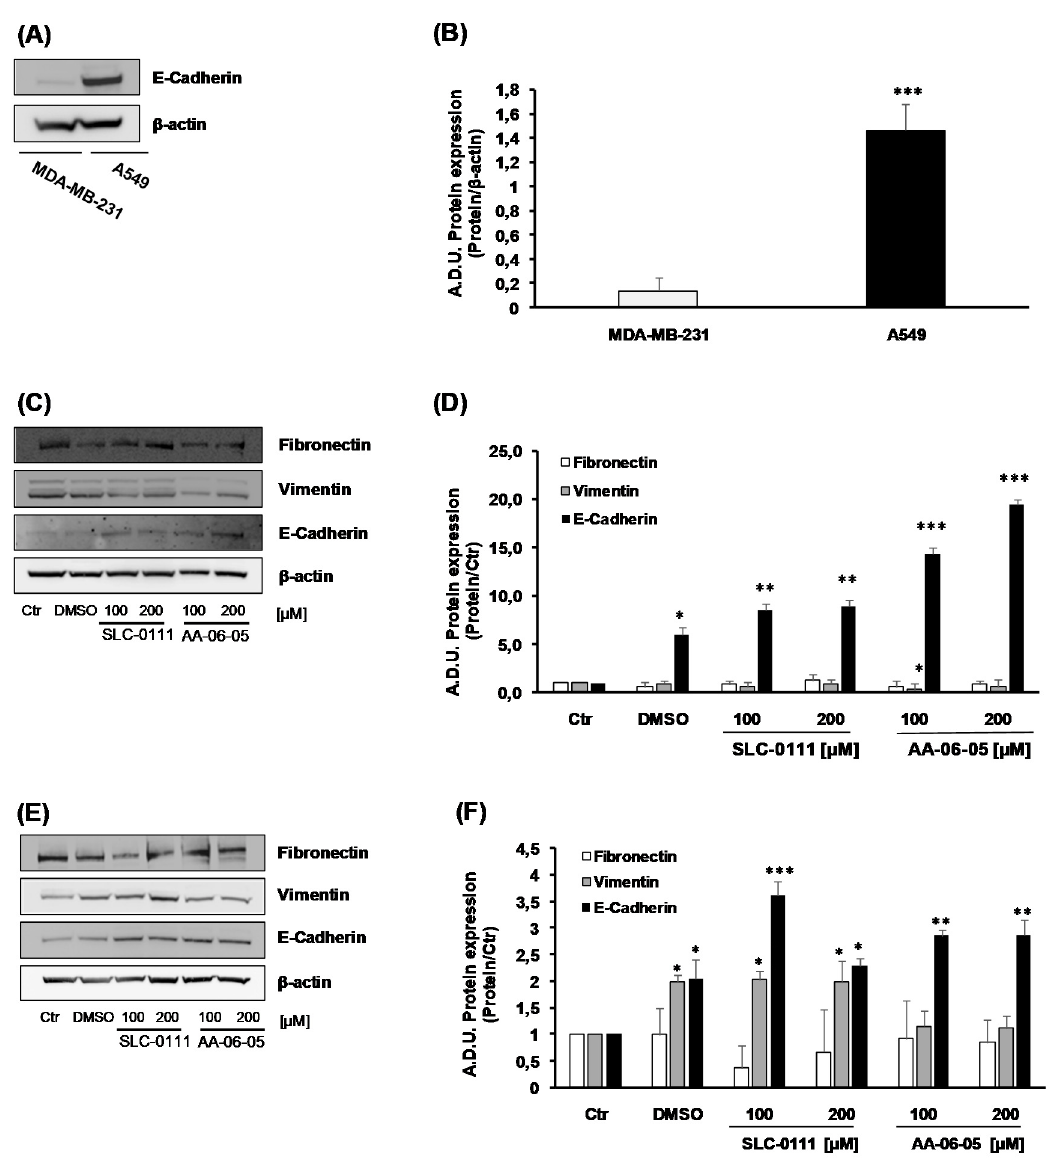
Figure 7. CA-IX pharmacological inhibitors control the mesenchymal phenotype of MDA-MB-231 and A549 cells. ( A , B ). Basal expression of E-Cadherin inMDA-MB-231 and A549 cells, cultured in medium with 1% FBS ( n = 3). Arbitrary Densitometry Units (A.D.U.) ± SD were reported as protein of